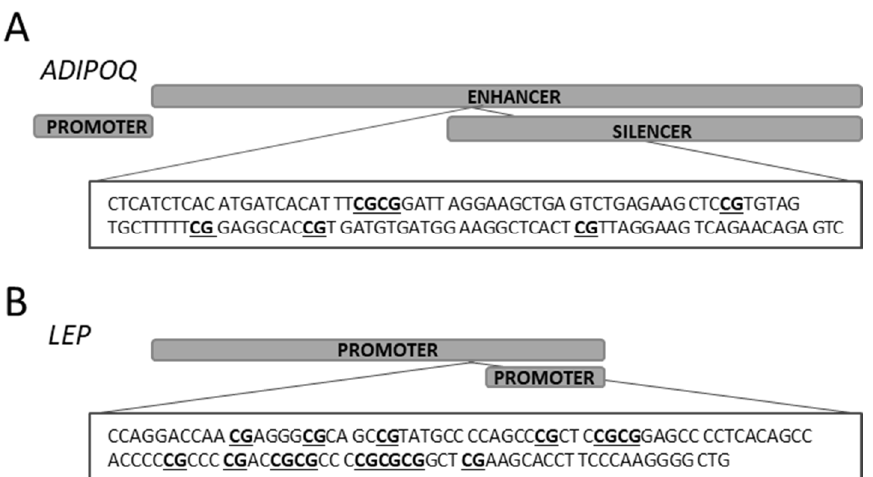
Figure 3. 5’-Cytosine-phosphate-Guanine-3’ (CpG) sites selected for methylation-specific quantitative PCR (MS-qPCR). Chromosomal localization and nucleotide sequence in human-based ADIPOQ reference sequence (NC_000003.12) with six CpG sites ( A ) and LEP (NC_000007.14) reference sequence (NC_000007.14) ( B ).